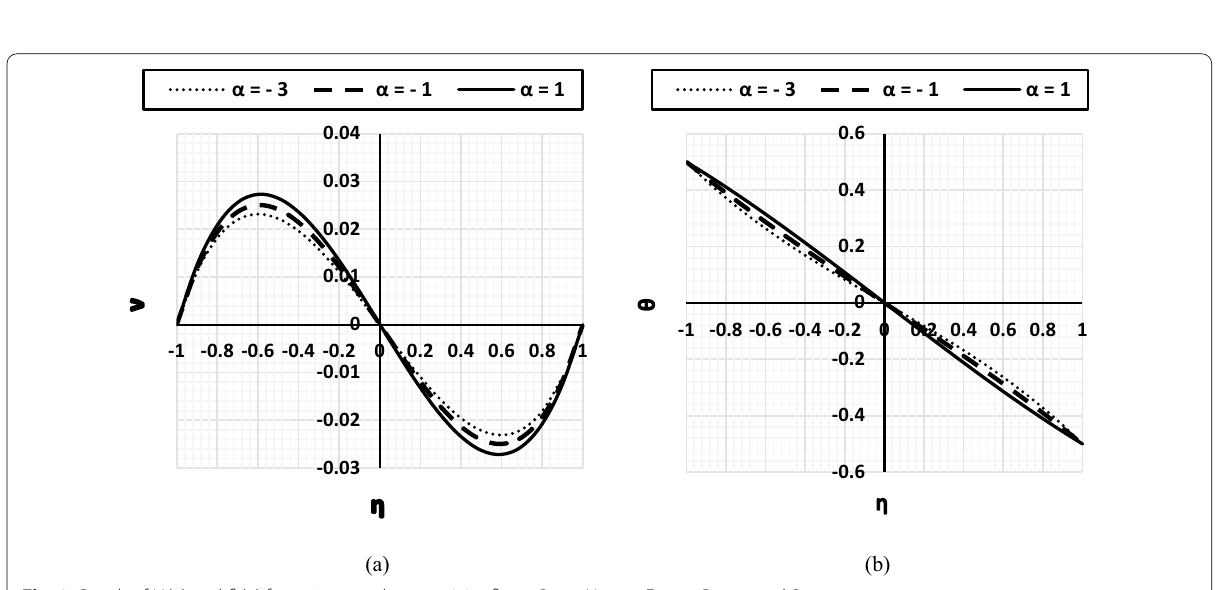
Fig. 3 Result of V ( η ) and θ ( η ) for various α when ϕ